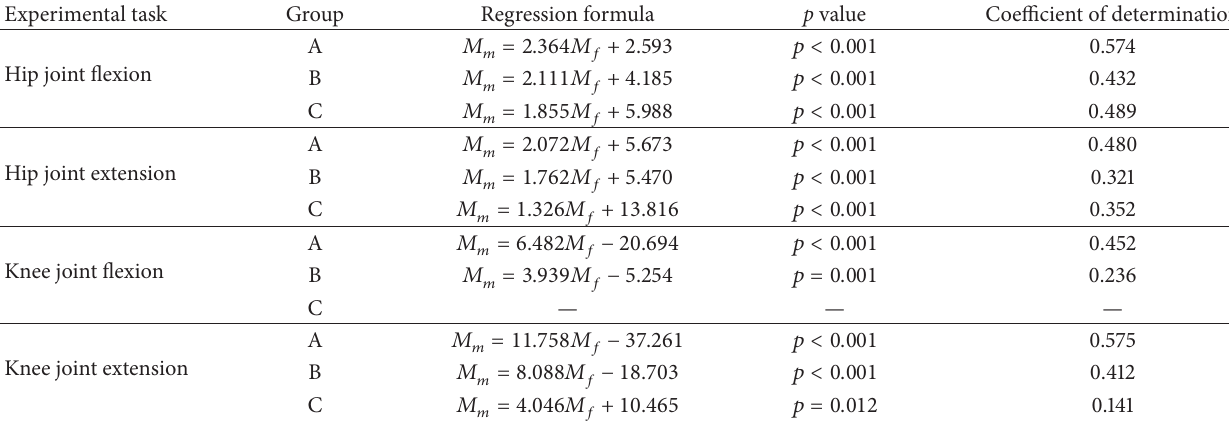
Table 3: Regression formula and coefficient of determination for each experimental